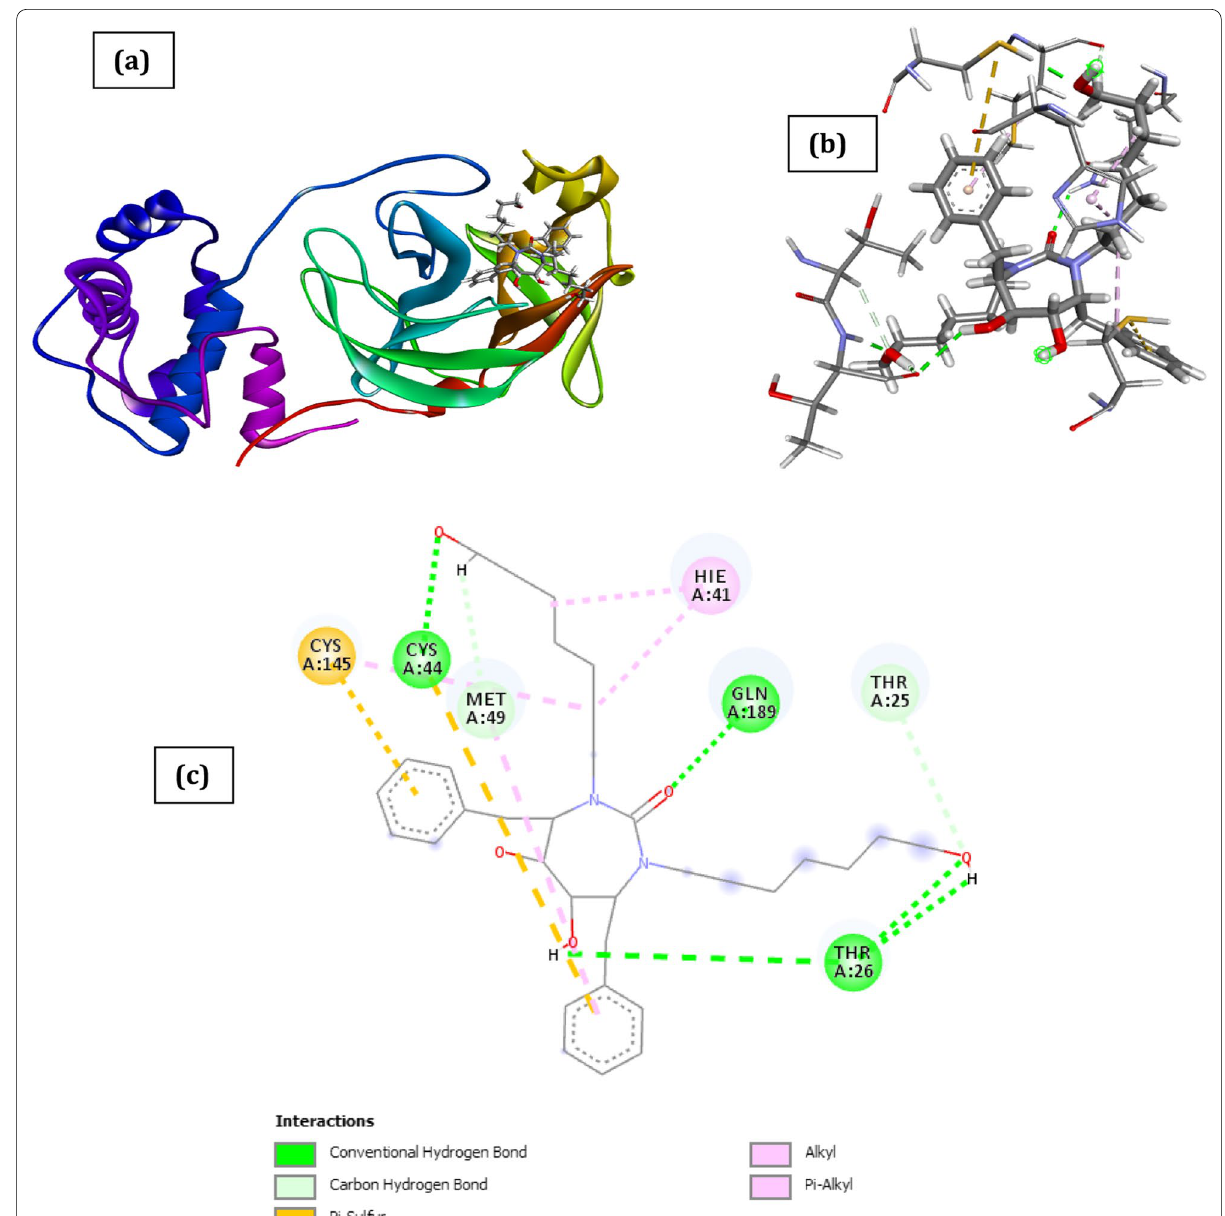
Fig. 4 Docked poses of SARS CoV 2 main protease (PDB ID: 6XBH) with inhibitor with Index number 46 (stick figure) a 3D view of docked pose of SARS CoV 2 Main Protease (PDB ID: 6XBH) with inhibitor with Index no. 46; b 3D view of inhibitor with Index number 46 with surrounding amino acids of 6XBH; c 2D view of interaction type of inhibitor with Index number 46 with surrounding amino acids of